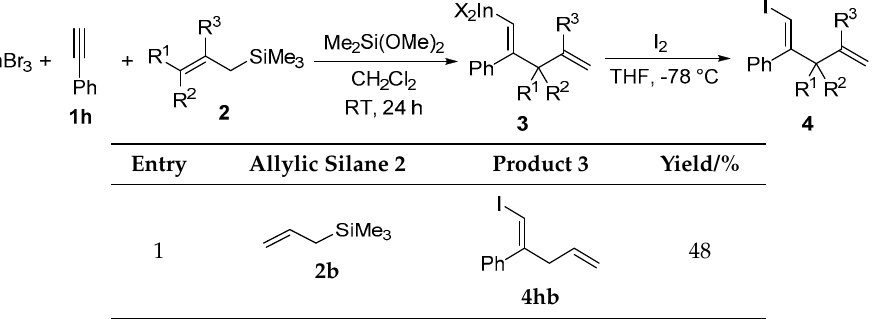
Table 3. Scope of allylic silane 2 in allylindation a .